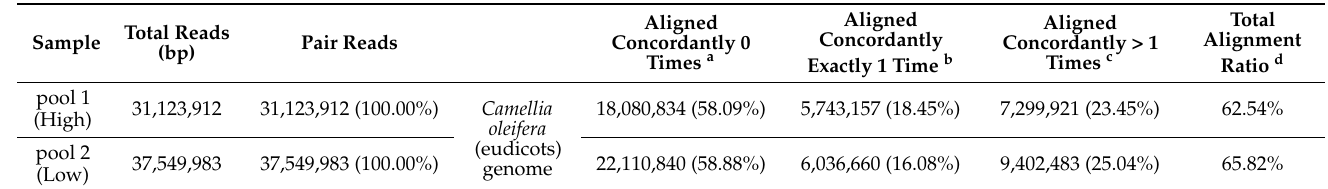
Table 2. Alignment results of two bulks Reads on whole genome sequences of C. oleifera var.